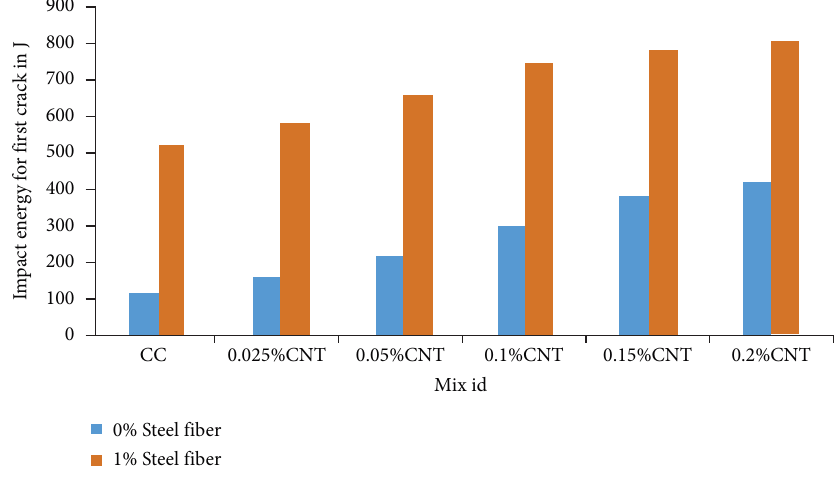
Figure 13: Impact energy for failure at 28days.